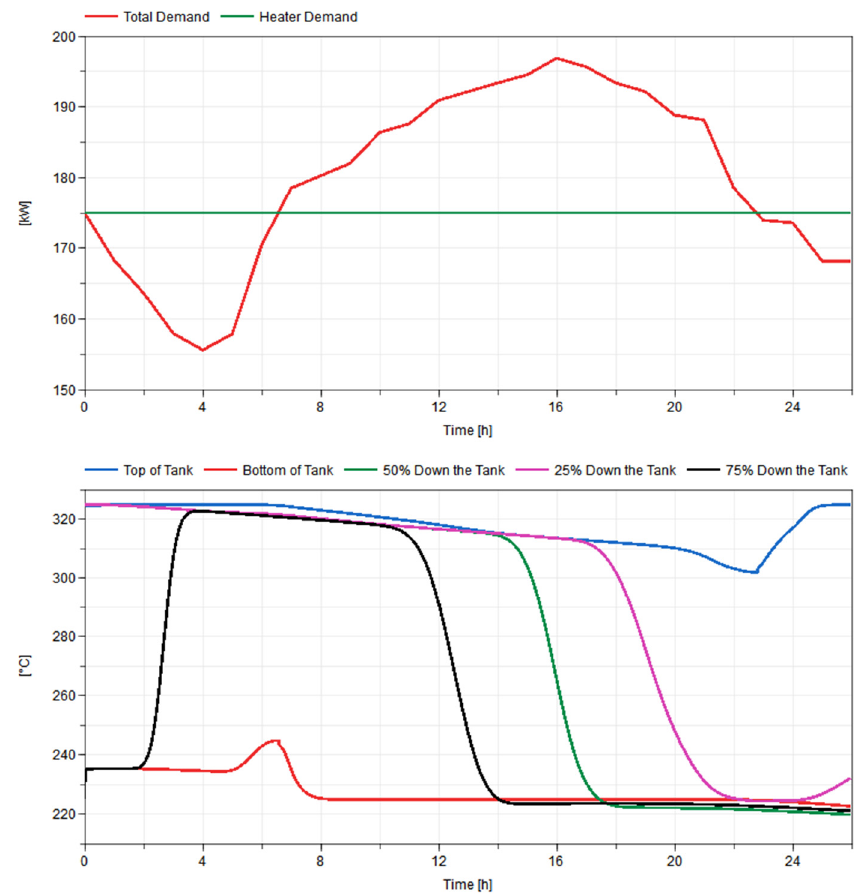
Figure 14. Hot-Summer-Day Scenario: ( Top ) System demand on the heater, thermocline, and total system. ( Bottom ) Thermocline fluid temperature at various points within the tank.